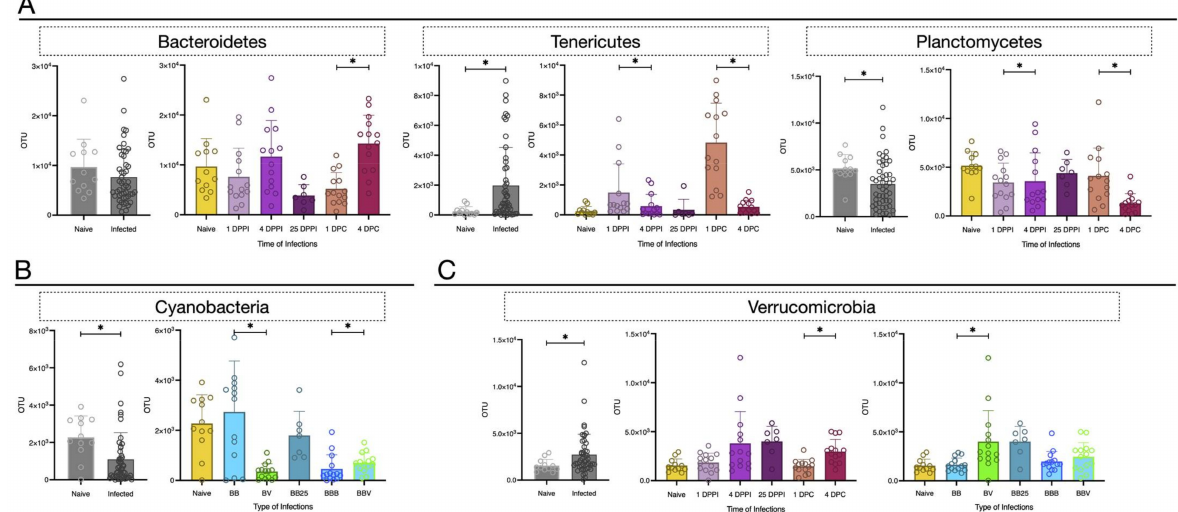
Figure 5. Dynamic of Specific Phylum during Biomphalaria infection: Dynamic of the number of OTU for specific Phylum according to 2 parameters. The time of infections: Day 1 (1 DPPI (=Day Post Primary Infection)) vs. Day 4 (4 DPPI) Primary infection and Day 1 (1 DPC (= Day Post-Secondary challenge)) and Day 4 (4 DPC) Secondary challenge. The type of infections: Sympatric (BB) vs. Allopatric (BV) Primary infections and Homologous (BBB) vs. Heterologous (BBV) Secondary challenge. ( A ). Phylums influenced by the time of infections. ( B ). Phylum influenced by the type of infections. ( C ). Phylum influenced by both time and type of infections. The Mann–Whitney U test is used to test the significant difference between the time or the type in Primary infections and Secondary challenge and mentioned with